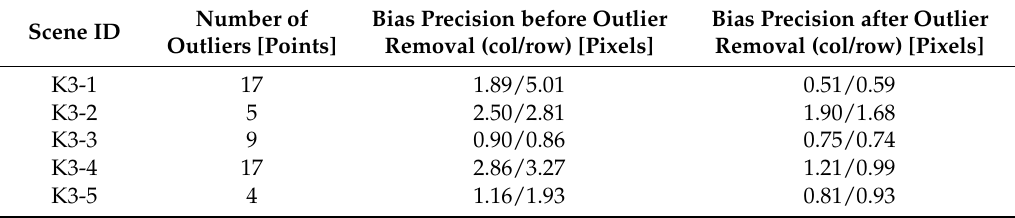
Table 2. Rational polynomial coefficients (RPC) bias-compensation precision before and after outlier